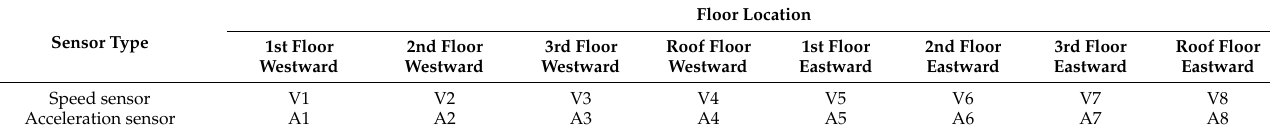
( c ) Figure 9. Field testing instruments and related equipments: ( a ) DH612 sensor; ( b ) electric displace- ment meter; ( c ) data acquisition instrument. 3.2. Sensors Arrangement In order to maximize measurement convenience and accuracy, the measuring points shall be located as close to the building’s end as possible [21]. Accordingly, the measure-